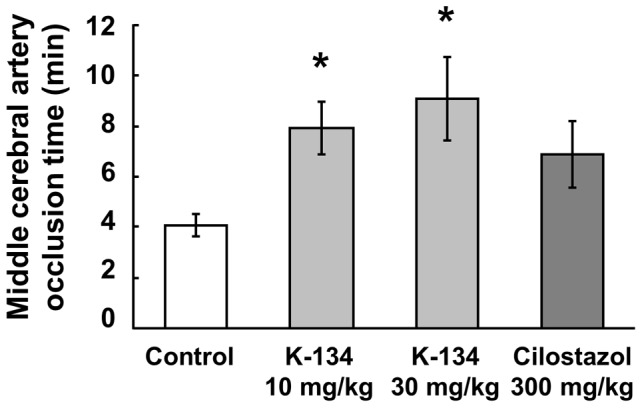
Inhibitory effects of K-134 on middle cerebral artery occlusion time in a photothrombotic stroke model.Preadministration of K-134 but not cilostazol significantly prolonged MCA occlusion time in a photothrombotic cerebral infarction model in comparison with vehicle-treated controls. Values are means ± SEM (*P<0.05, two-tailed Dunnett's test, n = 12).